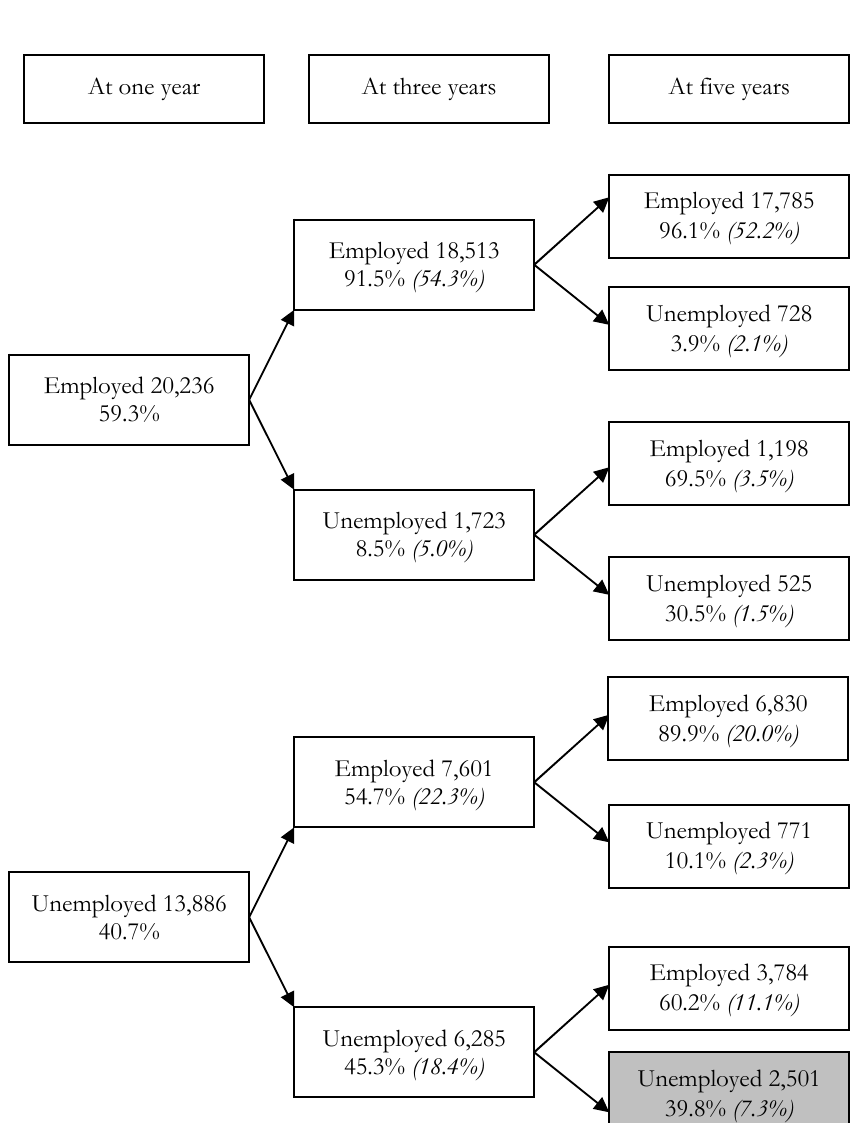
Figure 1 – Graduates from the years 2000, 2001 and 2002: employment conditions at one, three and five years from graduation. Note : the figures in italics reported in brackets are the percentages calculated with respect to the to- tal number of interviewees (34,122). Moreover, the box highlighted in grey, which shows the num- ber of interviewees with no work experience whatsoever in the three-year period under investiga- tion, refers to graduates excluded from the analysis on occupational